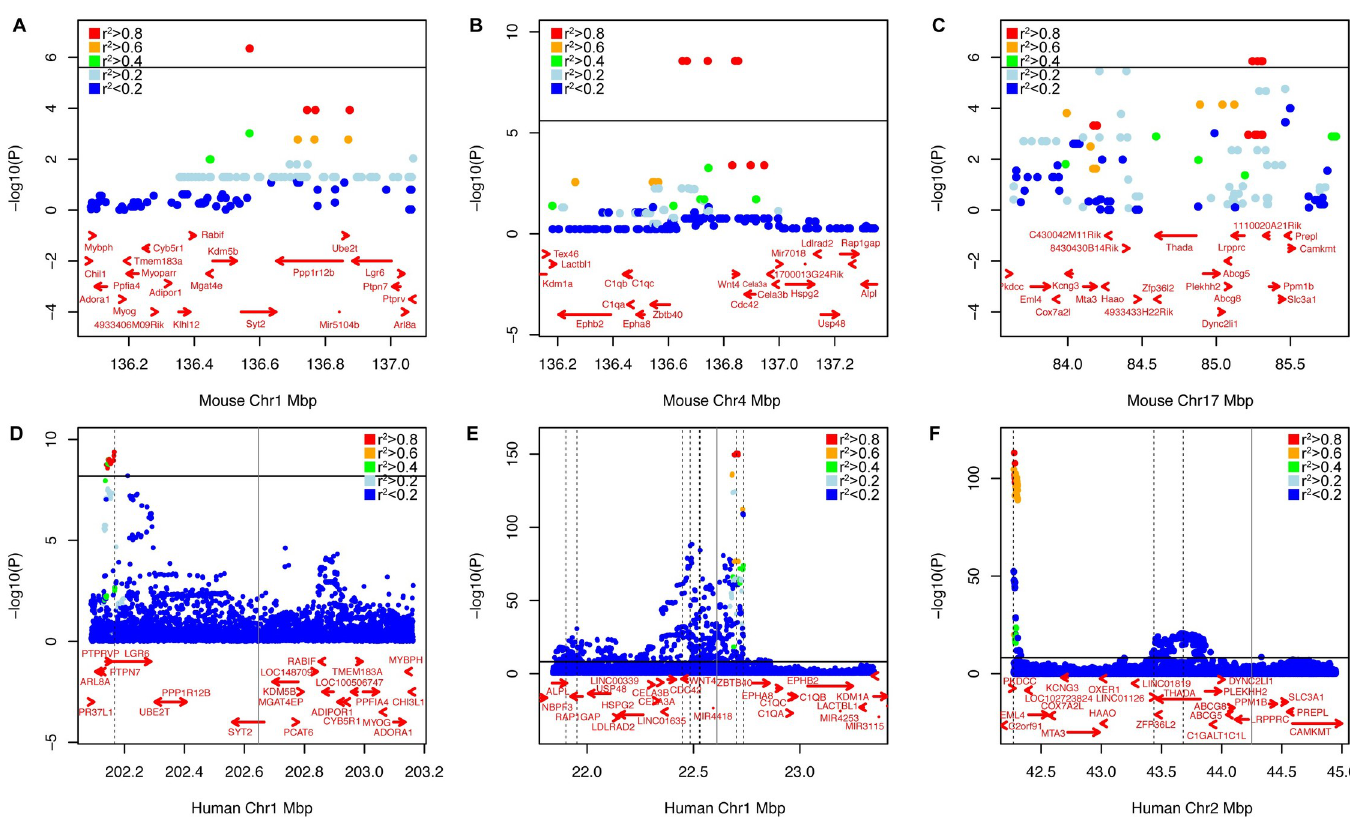
Fig 3. Human regions syntenic with mouse associations harbor genome-wide significant associations for BMD. Plots of GWAS results for mineralization associations on mouse Chrs. 1 (A), 4 (B), and 17 (C). eBMD associations [32] overlapping the human genomic regions syntenic with the three osteoblast mineralization loci on human Chrs. 1 (D), 1 (E), and 2 (F). Note the orientation is reversed in humans for the mouse associations on Chrs. 1 and 4. The horizontal solid black line in each plot is the genome-wide significant threshold. The dashed black vertical lines in panels D, E, and F denote the locations of independent eBMD loci in humans. The vertical grey solid lines denote the approximate peak location of the lead mouse mineralization SNP in humans. SNPs in all plots are color-coded based on LD with the most significant SNP in the genomic interval.